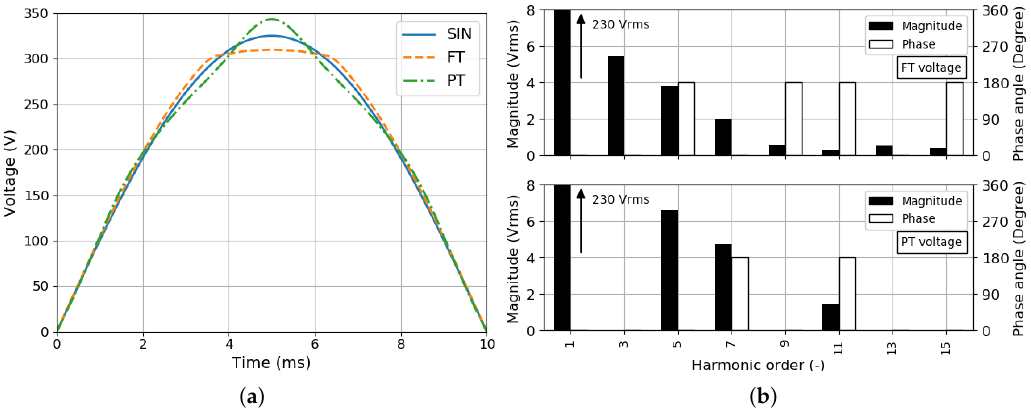
Figure 3. Characteristic voltage waveforms (sinusoidal (SIN), flat-top (FT), and peak-top (PT)) at rated voltage magnitude: ( a ) Time domain (SIN, FT, and PT). ( b ) Frequency domain (FT and